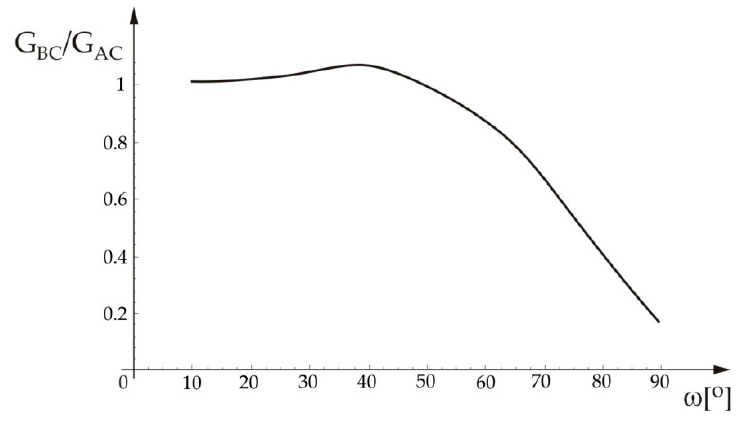
Figure 3. Ratio G BC / G AC in terms of angle ω .